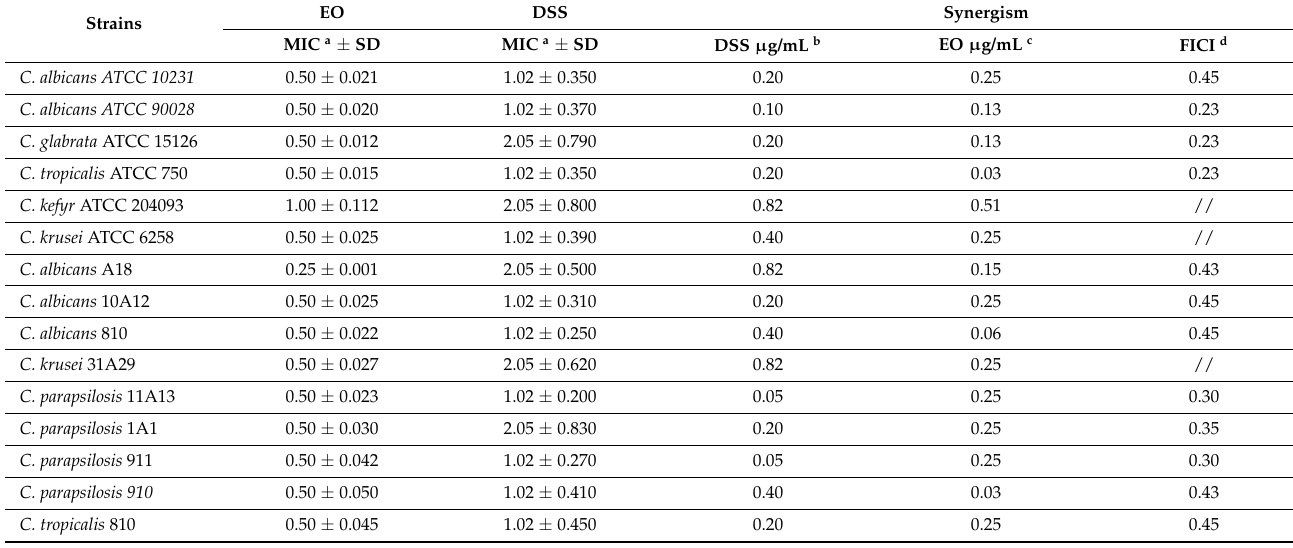
Table 4. Antifungal activity of M. alternifolia Essential Oil (EO) and Diclofenac Sodium Salt (DSS) on different Candida strains.